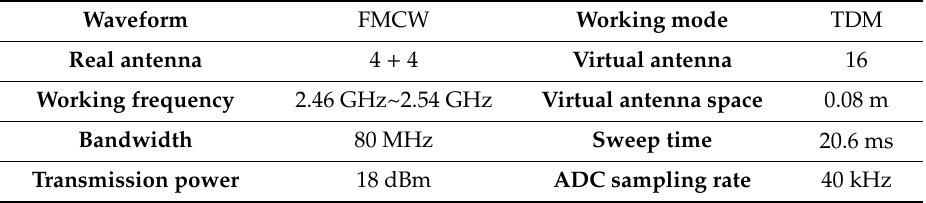
Figure 2. Diagram of the radar system. Table 1. Parameter of the multiple-input multiple-output (MIMO) radar.